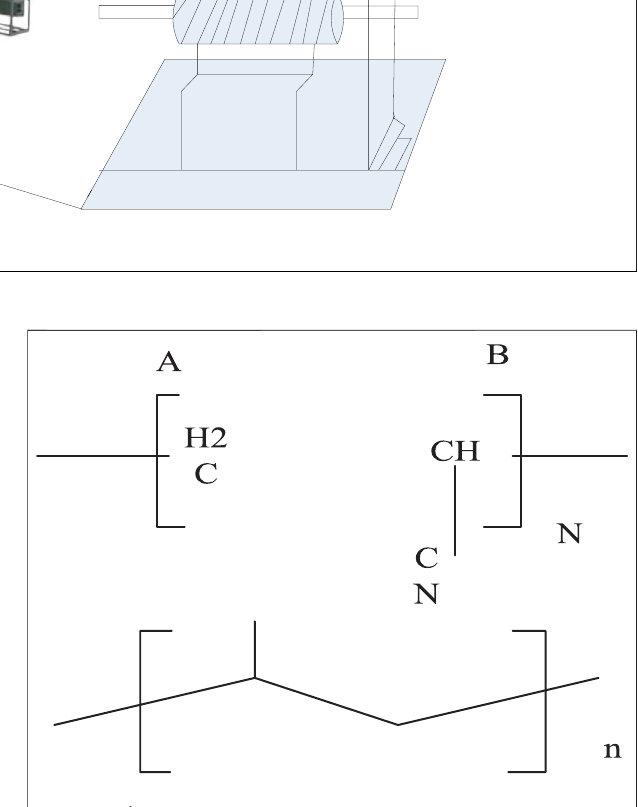
FIGURE 9 | Chemical structure of